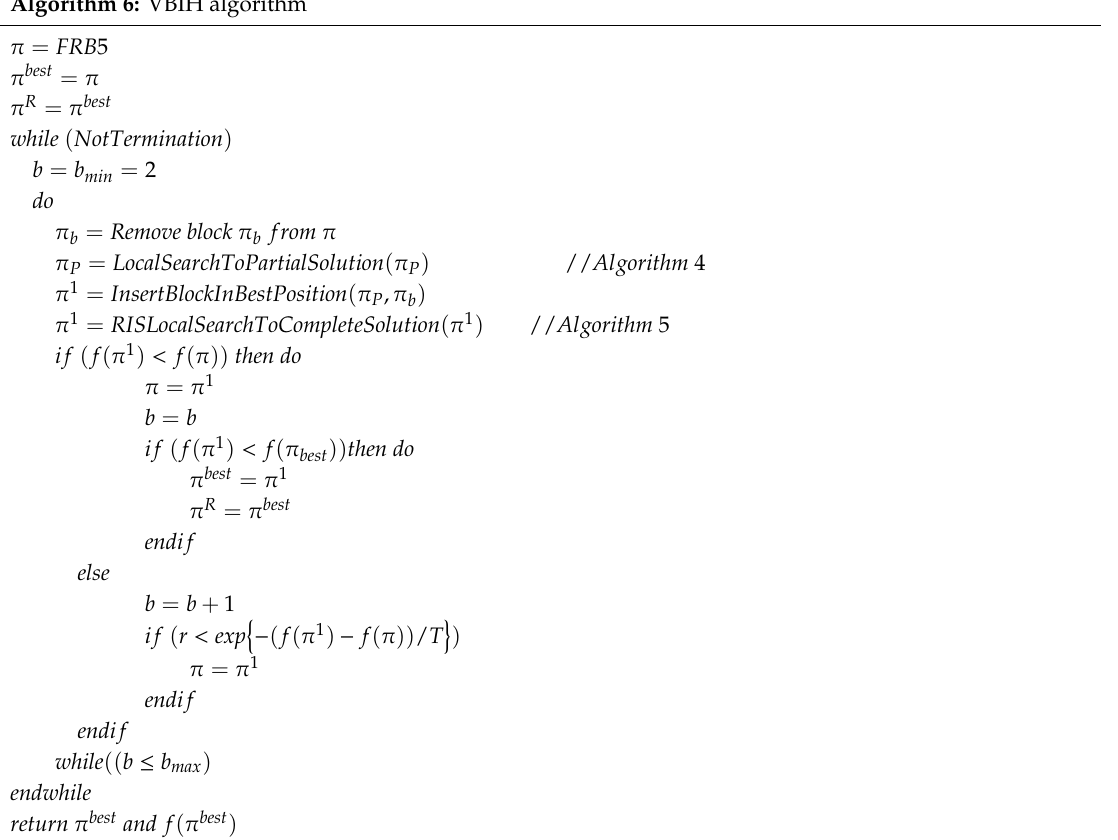
Algorithm 6: VBIH